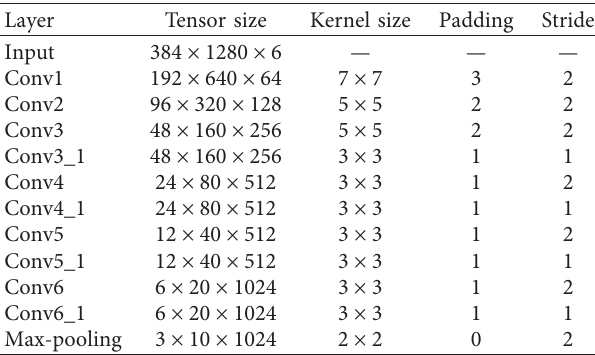
Figure 4: Framework of the proposed VO based on DSCNN algorithm. Table 1: Configuration of the CNN in